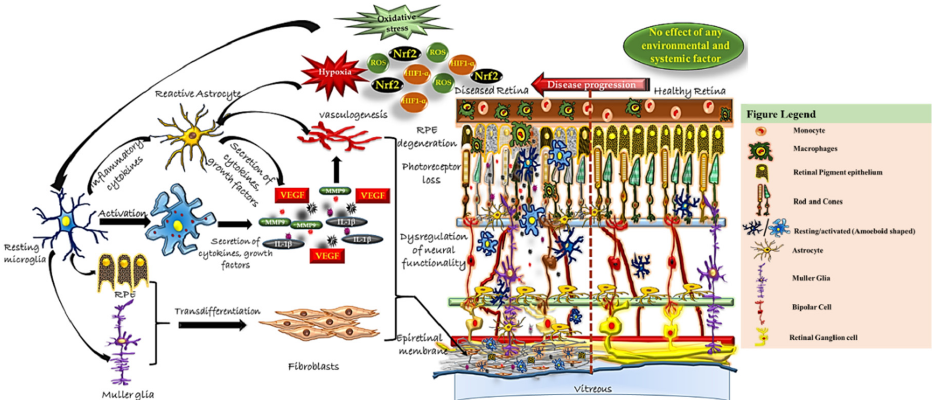
Figure 8. Schematic representation of proposed microglial activity in the epiretinal membrane of the retina. In healthy retina, resident microglia are involved in immune surveillance of all the layers of the retina and maintain retinal homeostatis by synaptic pruning, regulation of neurogenesis and axonal growth. With their phenotypic change of shape, they phagocytose cellular debris. Different kinds of stress/insults lead to abnormal functioning of retinal neurons, microglia, astrocyte, Müller glia and RPE cells. The resident/resting microglia in the retina get activated by transforming into an amoeboid shape and further interact with other neighboring retinal cells, causing abnormal functioning and trans-differentiation into proliferative cells types [10,11]. It also induces the secretion of several chemokines, proinflammatory cytokines and growth factors etc (results from the present study) that could aid in membrane formation by remodeling of the extracellular matrix proteins in retina and thereby contribute to disease pathogenesis.